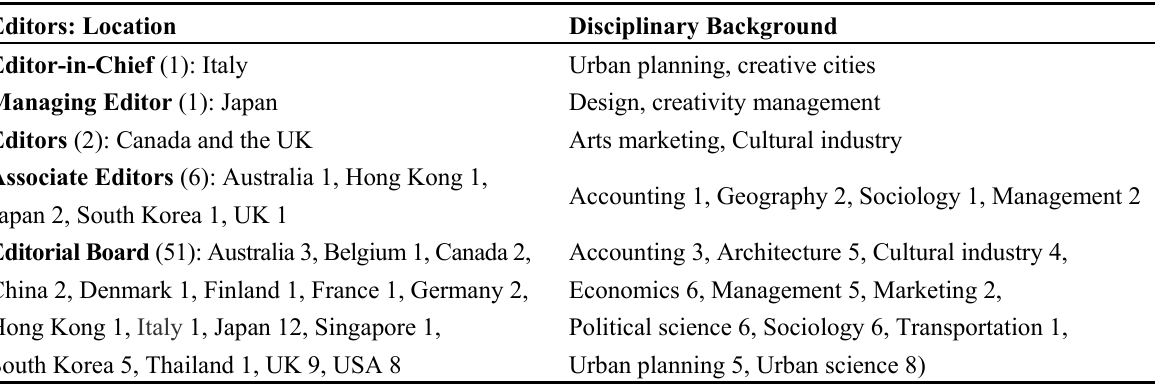
Table 1. The editorial structure of the